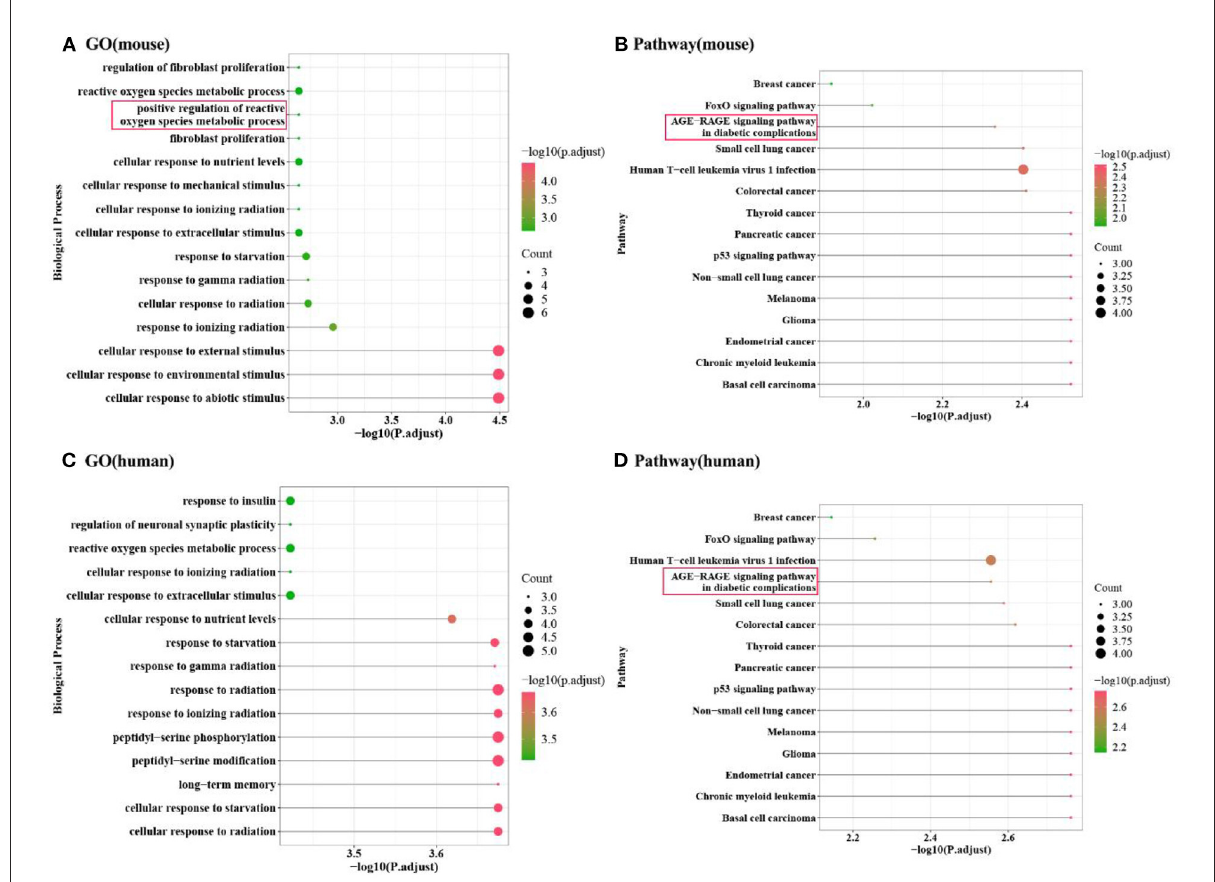
FIGURE3 Enrichment analysis results of Cross talk gene. (A,B) Mouse cross-talk gene enrichment analysis in GO biological process and KEGG pathway; (C,D) Human homologous cross-talk gene enrichment analysis in GO biological process and KEGG pathway.